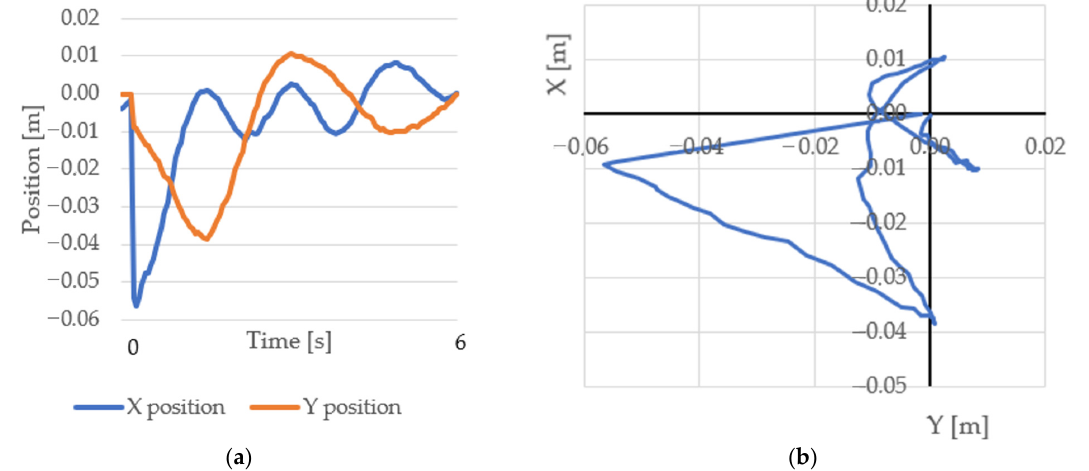
( b ) Figure 12. ( a ) Example run: X and Y positions in the real environment using a virtually trained agent. ( b ) Positions in 2 dimensions.